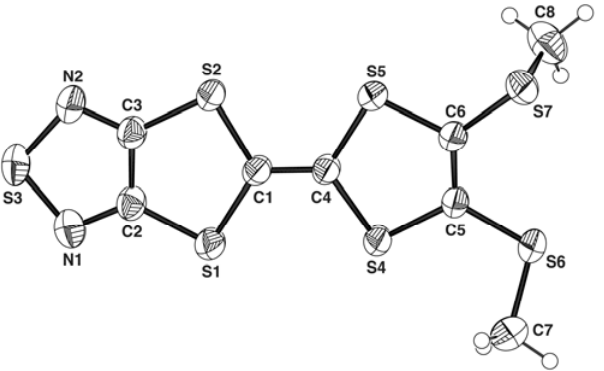
Figure 2. The molecular structure of 1 , with atom labels and 50% probability